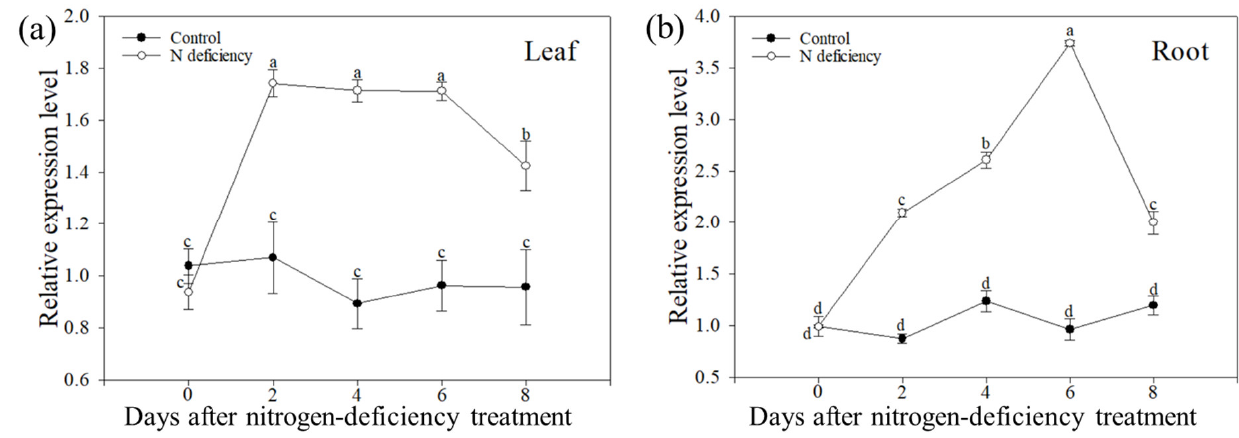
Figure 1. Changes in the expression of MdATG10 in ( a ) leaf and ( b ) root of apple plants after treating with or without nitrogen depletion stress for 8 d. Different letters indicate significant differences between treatments, according to one-way ANOVA followed by Tukey’s multiple range test ( p < 0.05).